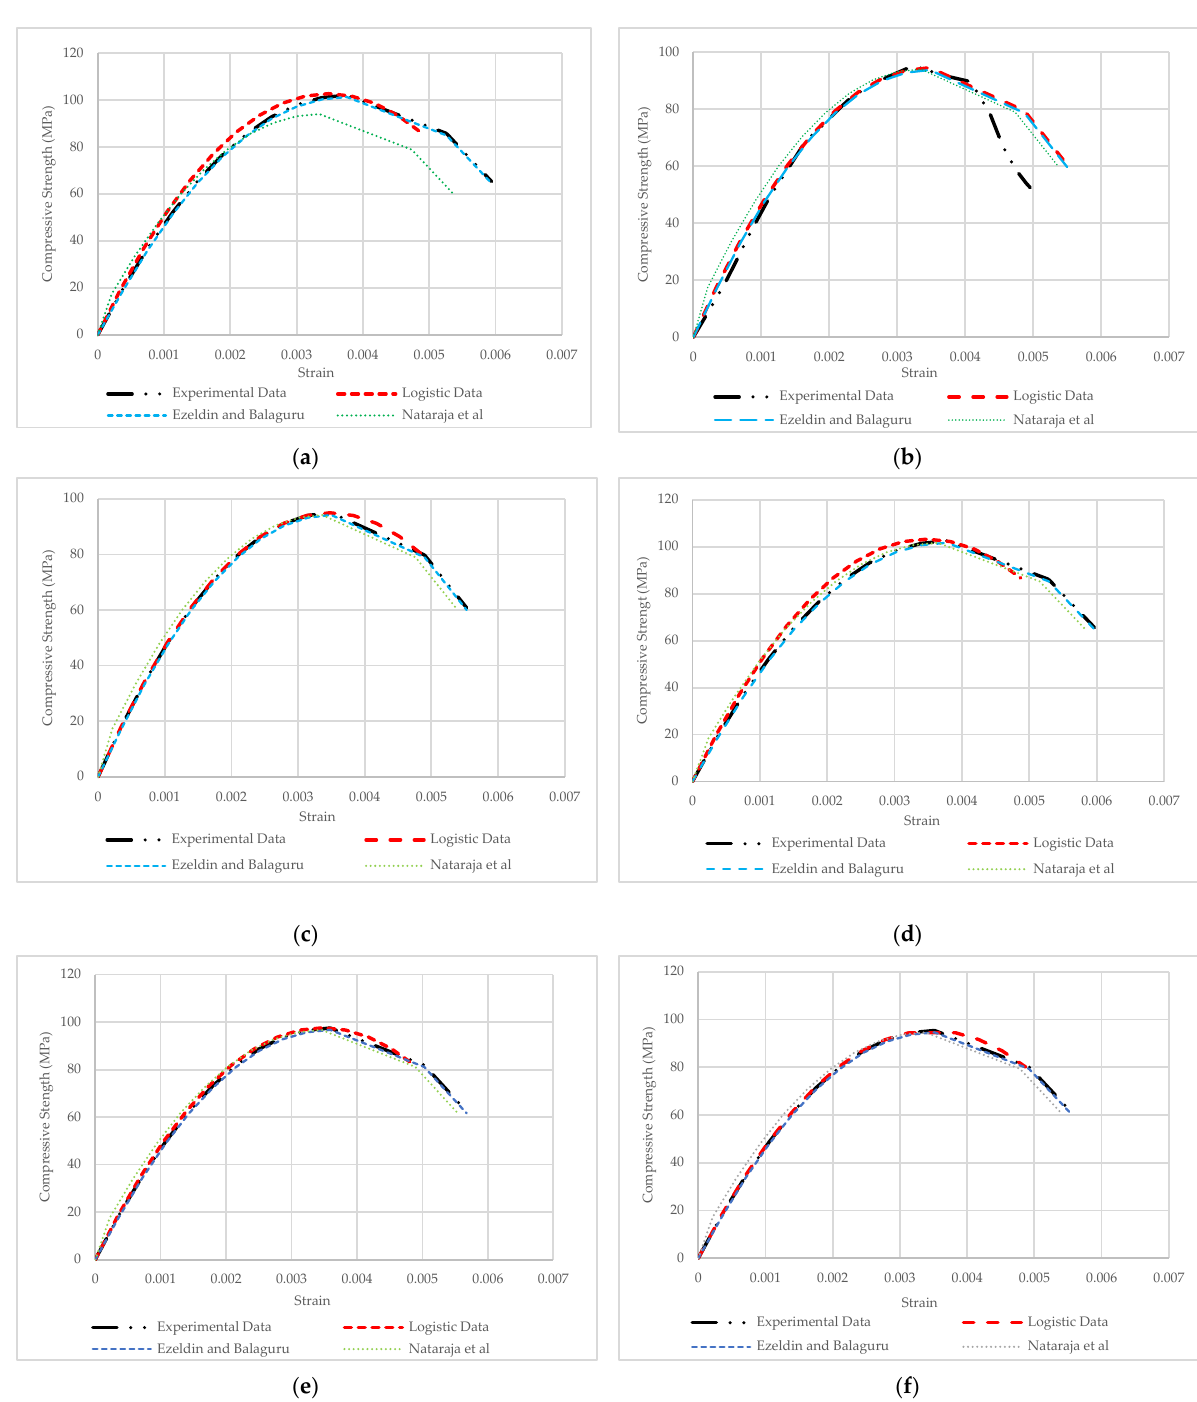
Figure 19. Simulation compressive stress – strain according to Logistic Map, Ezeldin and Balaguru [29], and Nataraja et al. [25]: ( a ) HPC; ( b ) BFHPC0.6; ( c ) BFHPC0.9; ( d ) BFHPC1.2; ( e ) BFHPC1.5; ( f ) BFHPC1.8.